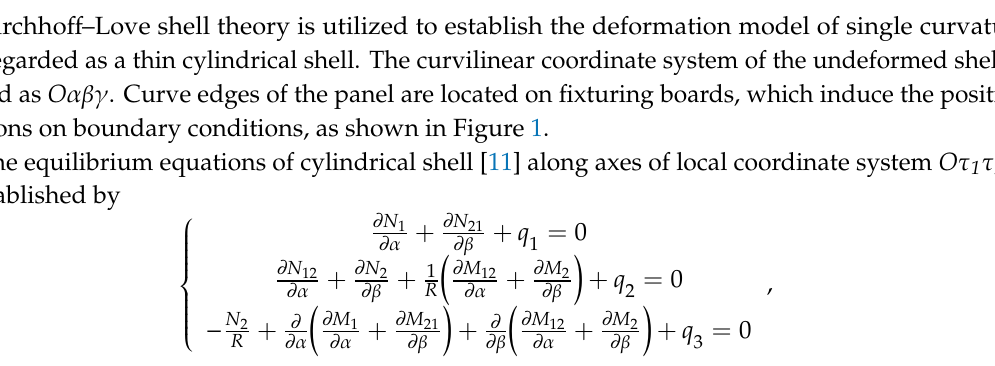
Figure 1. Assembled aircraft stiffened panel structure.